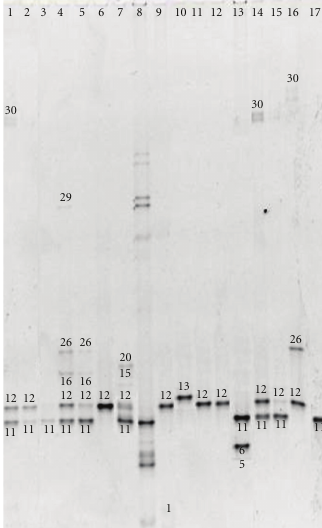
Figure 1: Denaturing gradient gel electrophoresis of vaginal samples from first trimester ( n = 16). Lines 1–7 and 9–17 samples. Line 8 internal DNA lab standard. Number of DNA-band in the figure related to Table 2, where the percentage of identification in women studied and GenBank access number data identification are